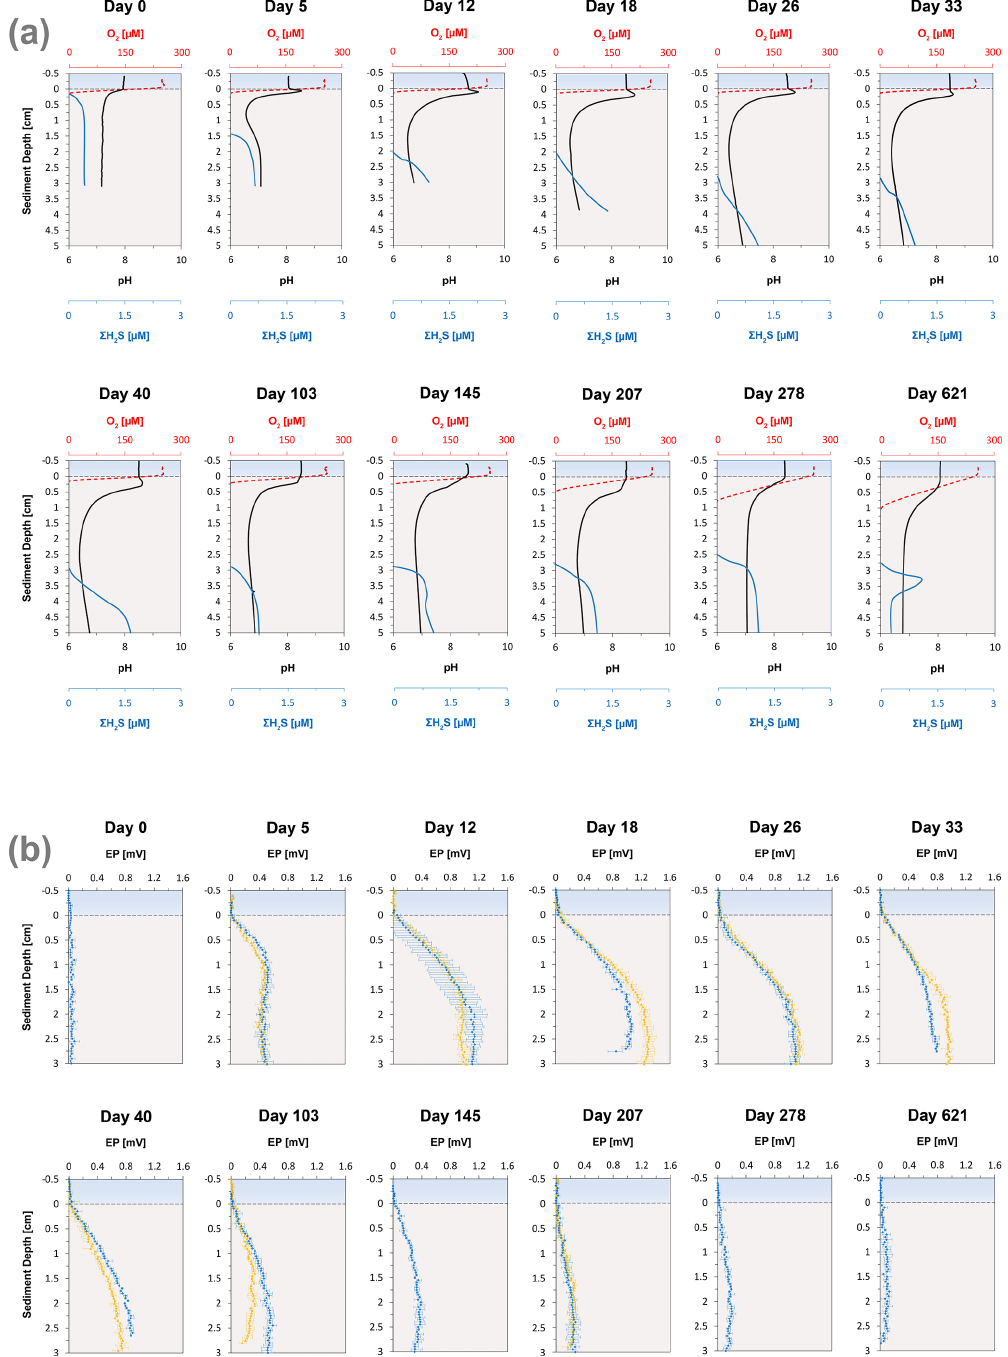
Figure 2. (a) Time series of the pore water pH (black), O 2 (red) and (cid:80) H 2 S (blue) signatures of the incubated sediment. (b) Development of the EP depth profile in the incubated sediment over time. The dashed line at 0mm depth represents the sediment–water interface. The blue boxes indicate the overlying water, whereas the underlying light grey boxes represent the sediment. The EP depth profiles represent an average of three replicate measurements. The error bars indicate the minimum and maximum EP values that were observed. The orange depth profiles represent duplicate measurement performed on a different